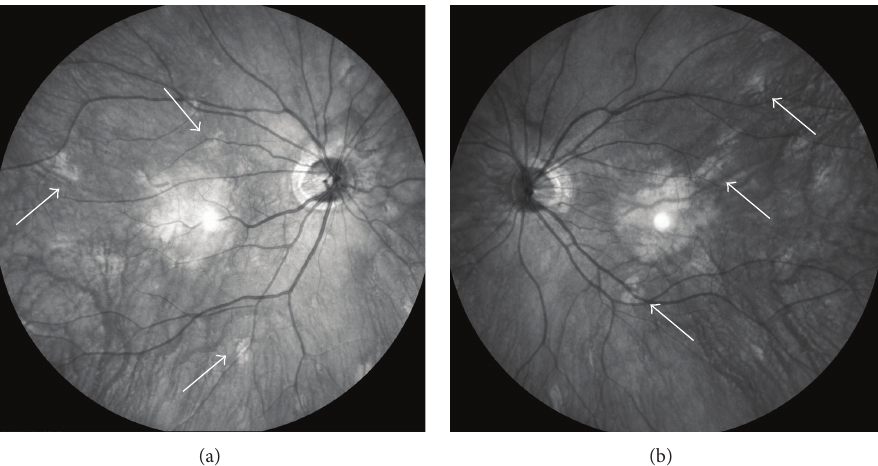
Figure 3: Right (a) and left (b) infrared fundus autofluorescence images. Note multiple bright, patchy lesions in the posterior poles of both eyes. The hyperreflective point at the center of the image is an optical